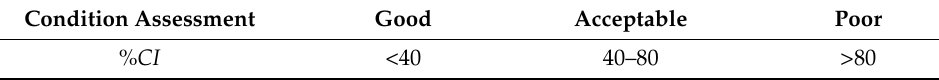
Table 3. Condition judgement from the % CI assessment